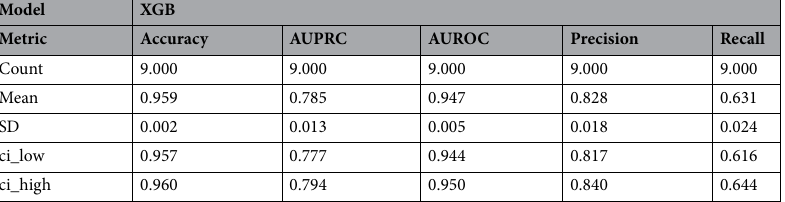
ESRD risk prediction 27 . However, our prediction model incorporated new parameters such as blood albumin level, and non-invasive markers of hepatic fibrosis such as nonalcoholic fatty liver disease, fibrosis score, and fibrosis-4 index. Implementation of the machine learning‑based clinical decision support system. The devel- oped model was implemented with a dedicated server for the Machine Learning-based Clinical Decision Sup- port System (Supplementary Fig. 3). The server extracted structured data through the Fast Healthcare Interoper-